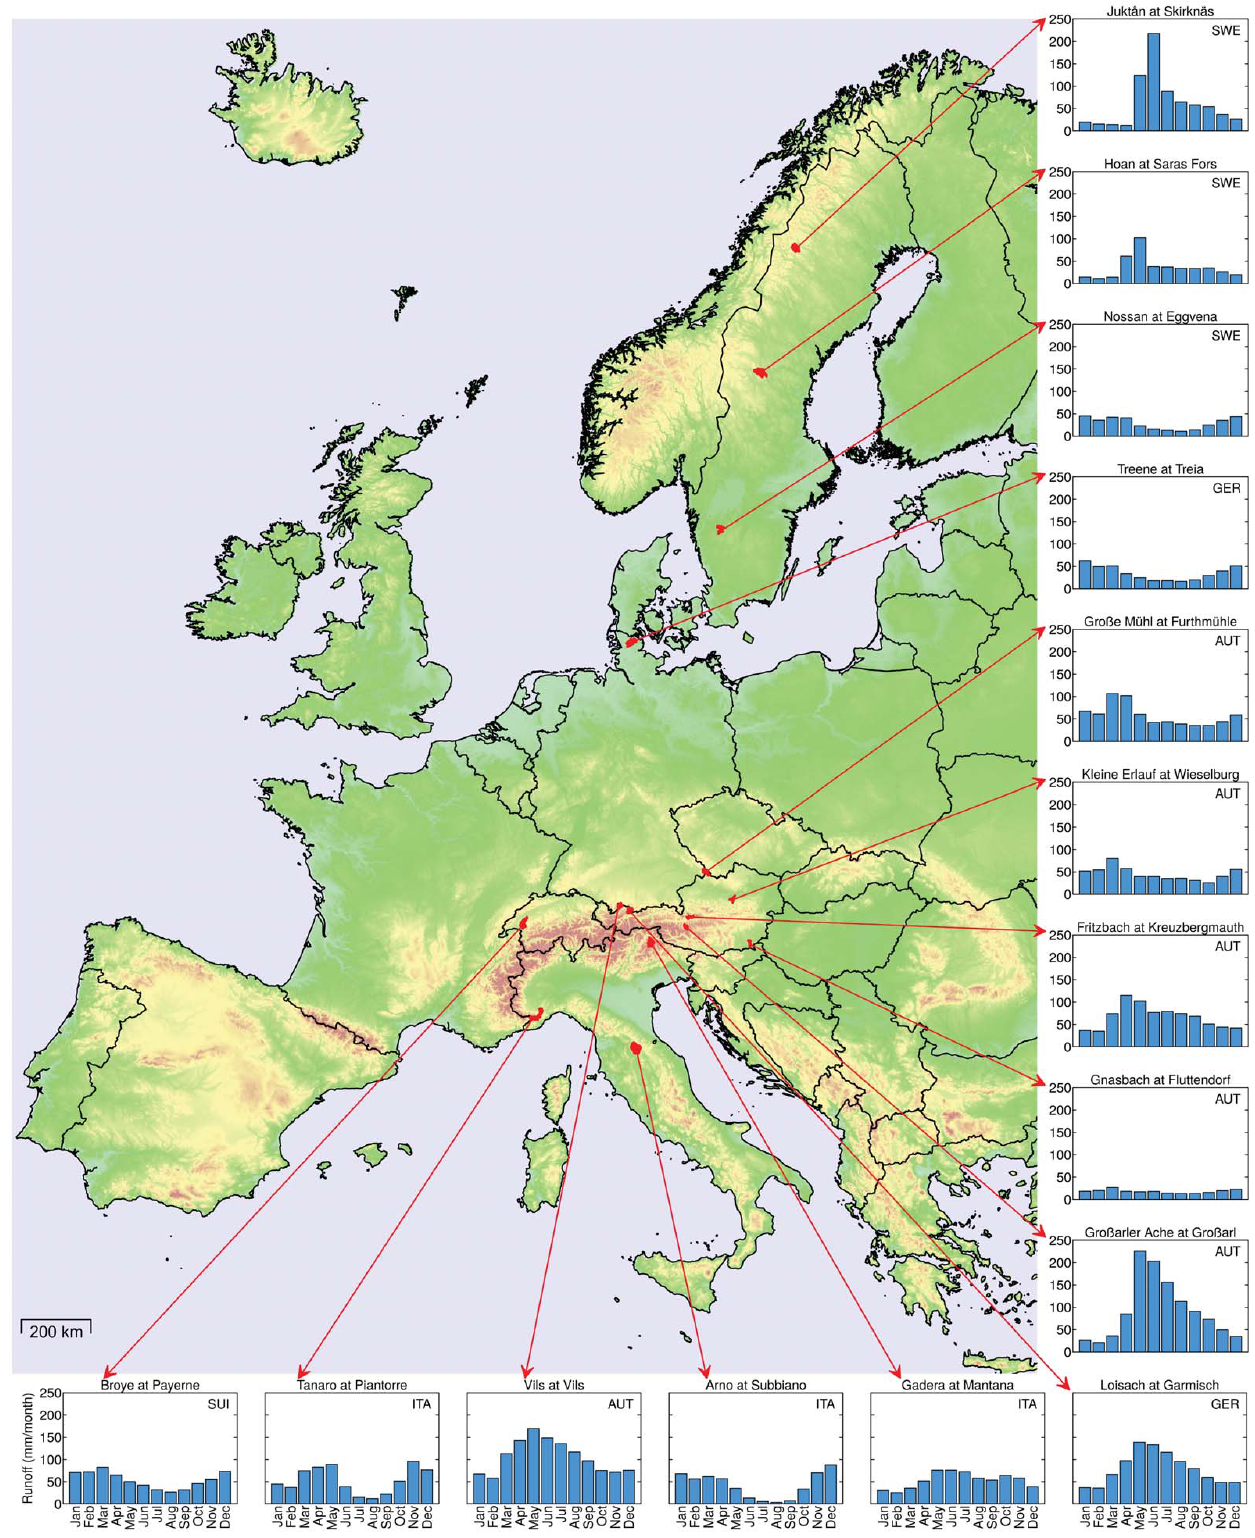
Figure 1. Geographical location and runoff seasonality (average among the observation period listed in Table 1) (mmmonth − 1 ) for the 15 catchments considered in the first collaborative experiment of the SWITCH-ON Virtual Water-Science